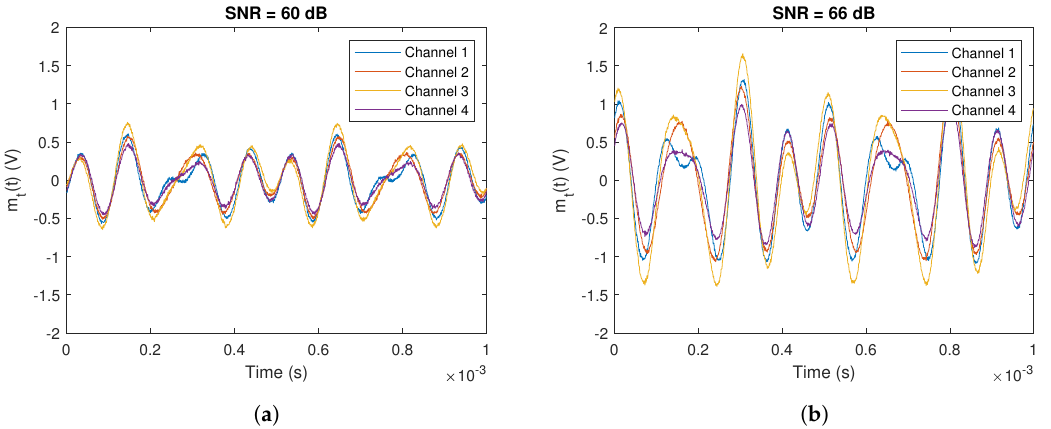
Figure 26. First samples of the measured signal of the empirical tests with SNR of: ( a ) 60 dB; and ( b ) 66